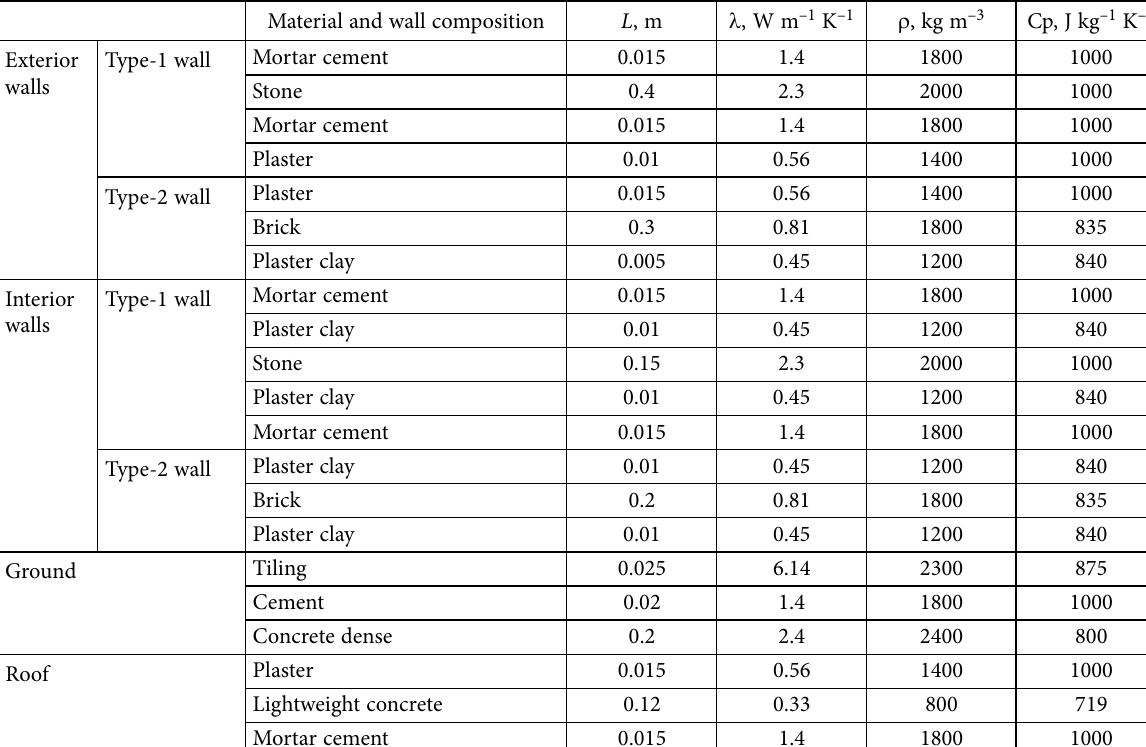
Table 3. Thermal properties, thicknesses of walls and building envelope